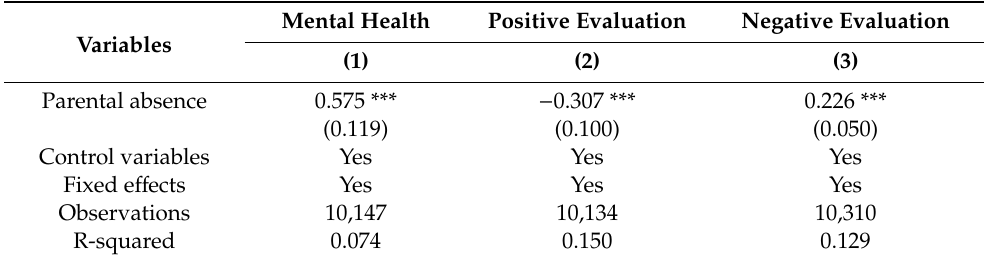
Table 10. Alternative measures for mental health and perception of campus